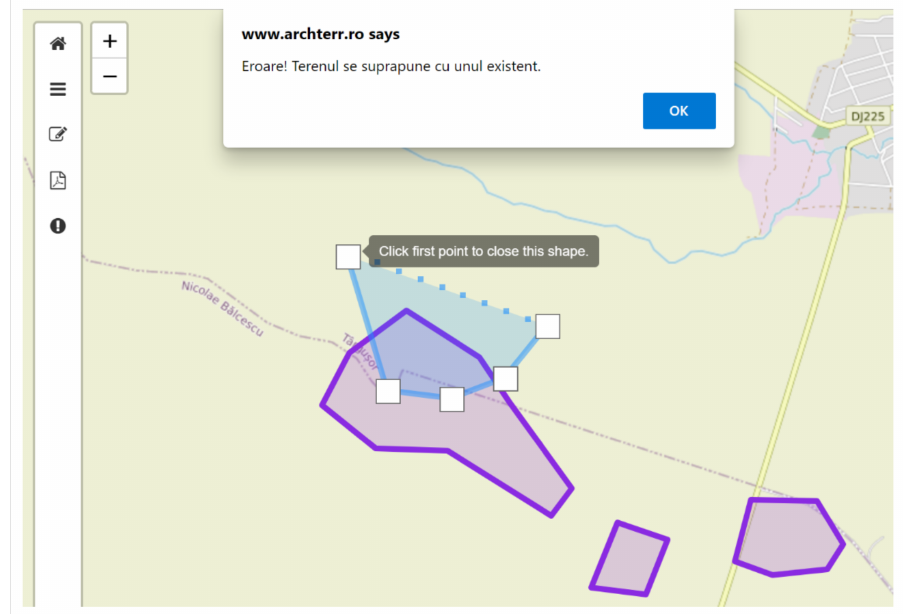
Figure 18. System warning issued in the case of a comparison of overlapping areas with validated archeological sites